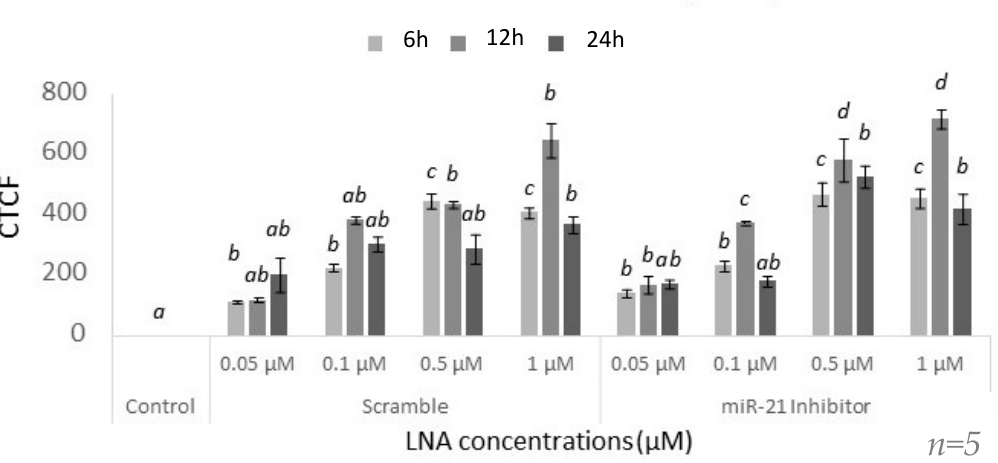
Figure 2. Confocal microscopy of LNAs at different concentrations and quantification of fluores- cence intensities . Transfections with FAM-labeled LNA probes at 0.05 µ M, 0.1 µ M, 0.5 µ M, and 1 µ M for 6, 12, and 24 h. ( A ) depicts a representation of confocal images taken at 12 h post transfection. In vitro cultured granulosa cells were transfected, fixed on slides, counterstained with Hoescht stain, and imaged on an Olympus FV1200 Confocal Microscope. Quantification was done through the ImageJ software; the CTCF ( B ) showed significantly increased transfection efficiencies at the higher concentrations (0.5 μ M and 1 μ M). Different letters indicate significant differences, with b indicating a significantly different mean than a at p < 0.001 and c indicating a significantly different mean than a and b at p < 0.05. ab indicates no differences between a or b . Bars represent the mean ± SEM.